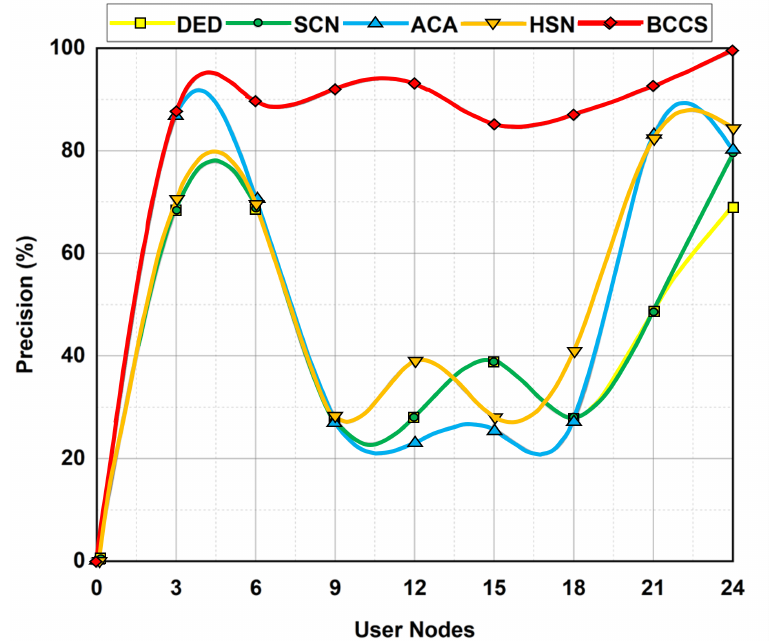
Figure 4. Precision (user